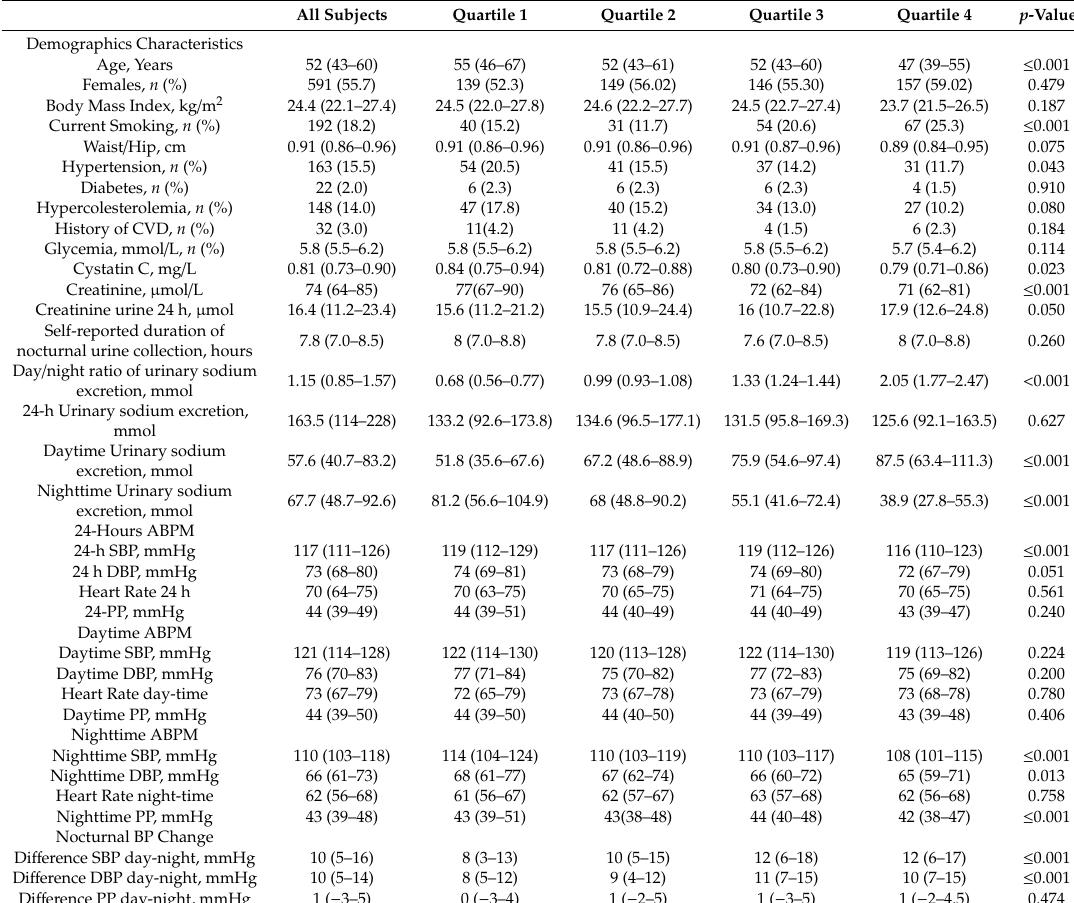
Table 1. Participant’s Characteristics (n. 1062